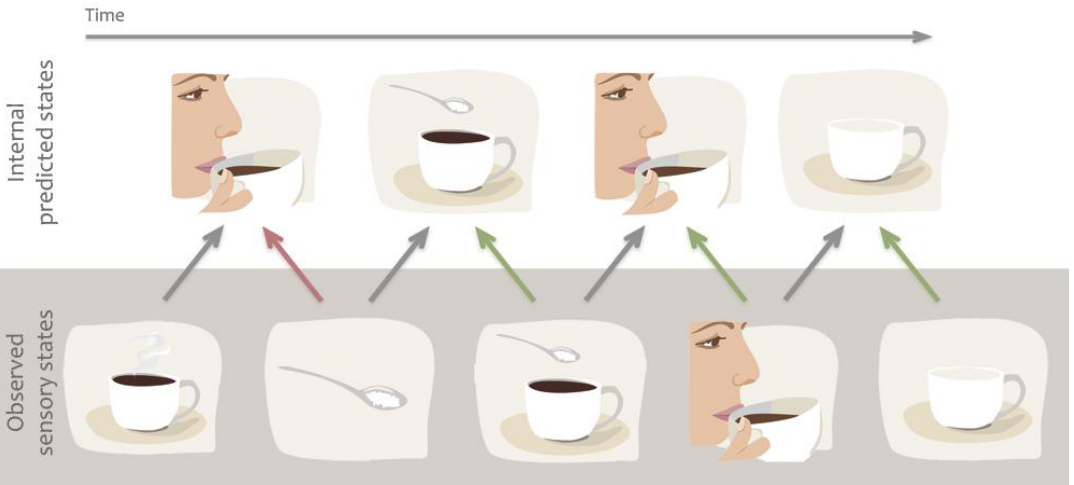
Figure 3. Example of predictive coding or forward models. We are constantly making predictions about the future state of our sensory system based on previous associations. Predictions are also quickly updated based on incoming sensory information to minimize prediction error. For example we predict that our friend will take sip from her coffee but when her hand grabs the sugar bowl we quickly alter our